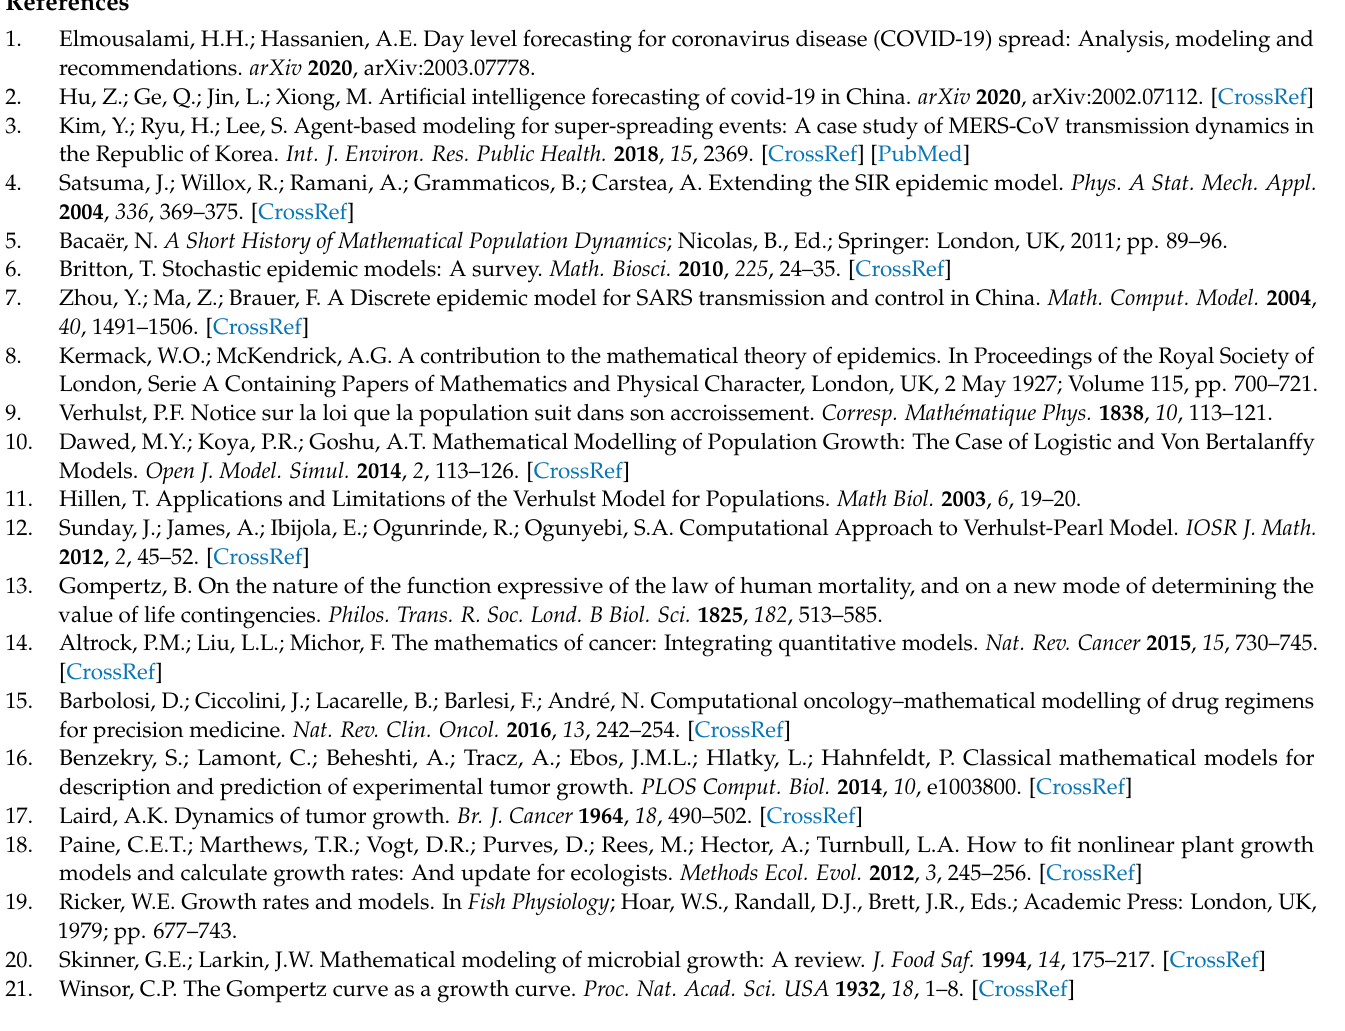
Figure A6. Histograms 25 January 2021 wave 3 SIR — Spain.